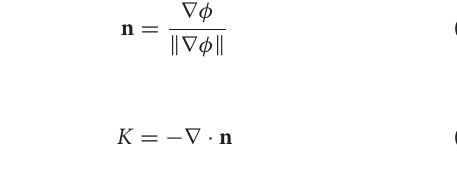
After solving Equation (1) and subtracting the average vertical value, the creep velocities are known within the ice